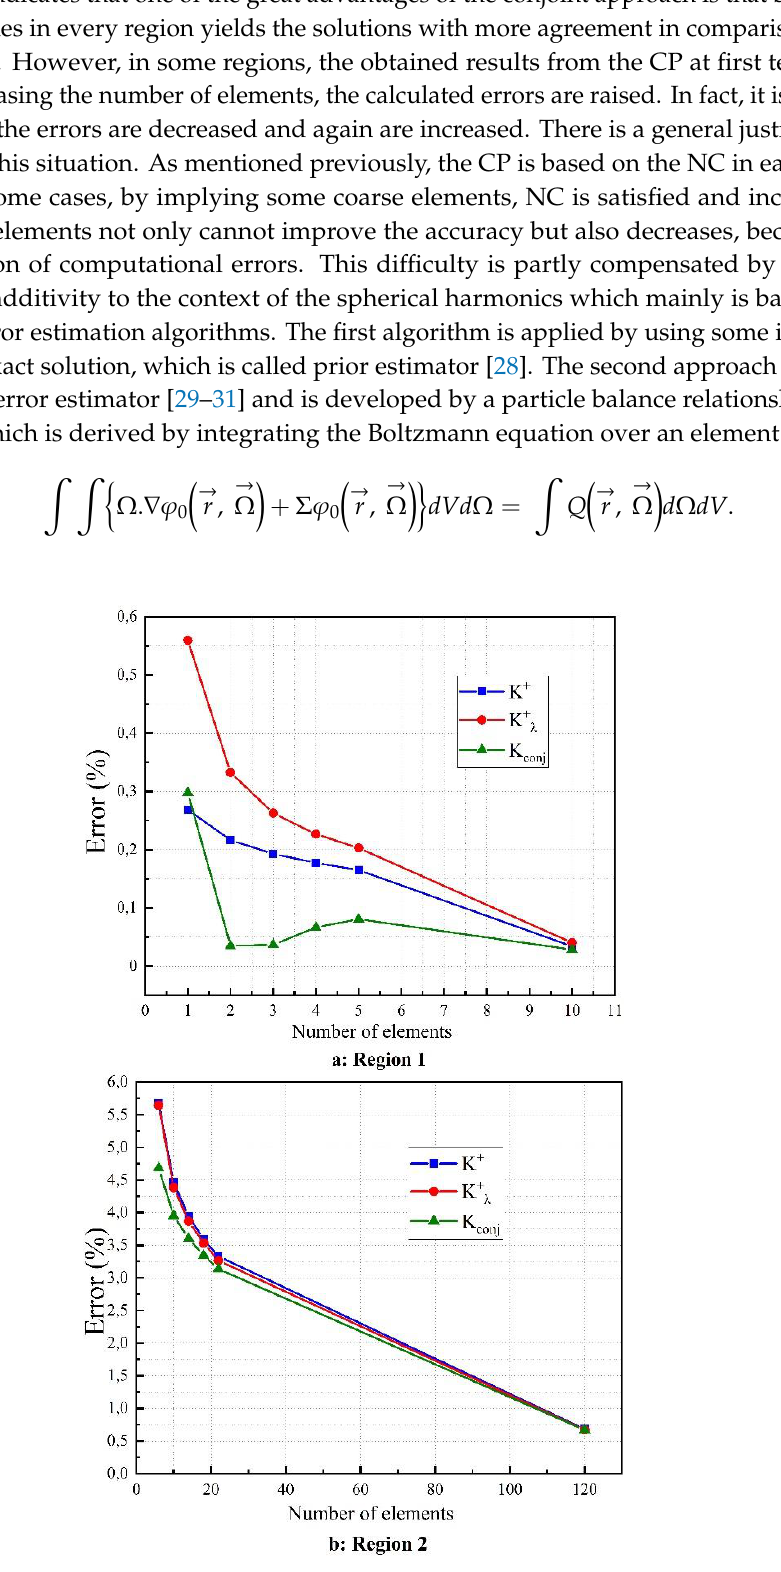
Table 6. Relative errors for 𝑃 3 , 𝑃 5 approximations with a set of elements for region 5. Order of